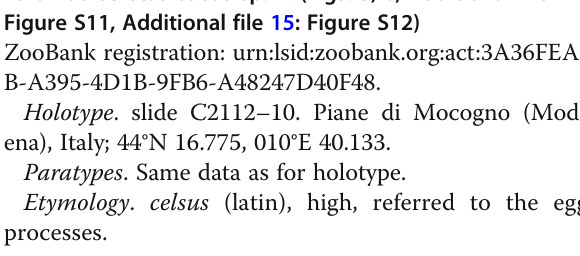
Figure S11, Additional file 15: Figure